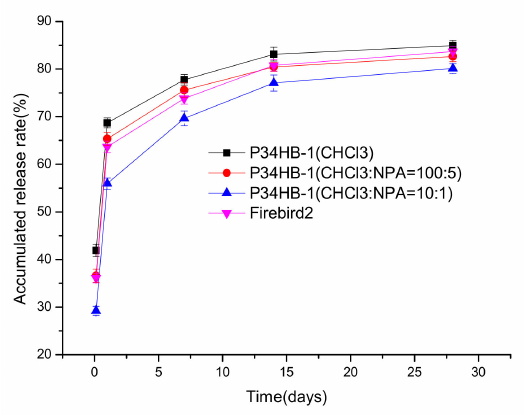
Figure 7. Drug release profiles of P34HB-1 DES and Firebird2 ®